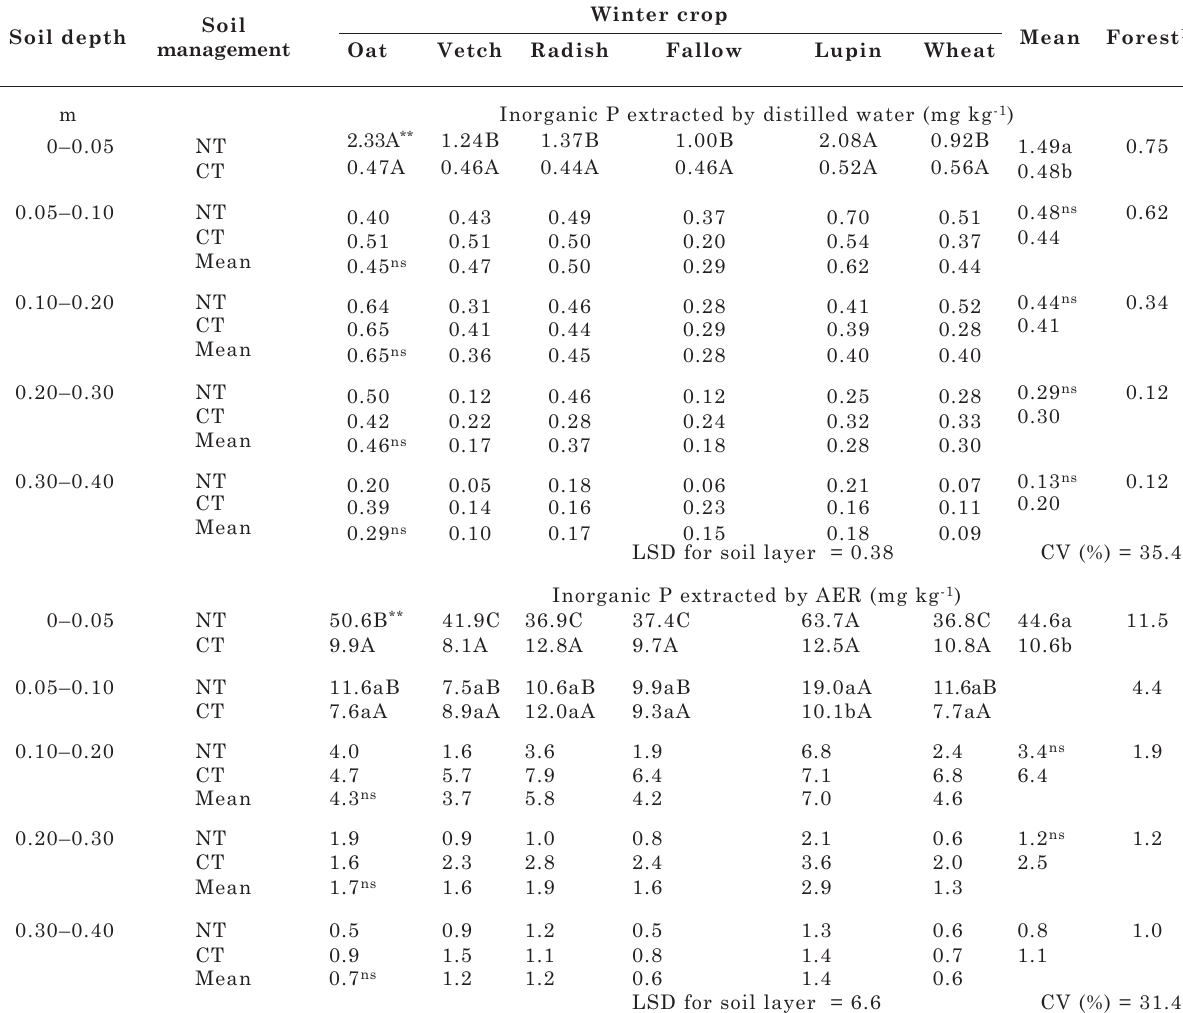
table 6. Phosphorus extracted by distilled water and by anion exchange resin (aer) after 23 years of different soil management and winter crops of a rhodic hapludox winter crop soil soil depth mean Forest 1 management oat Vetch radish Fallow lupin wheat m Inorganic P extracted by distilled water (mg kg -1